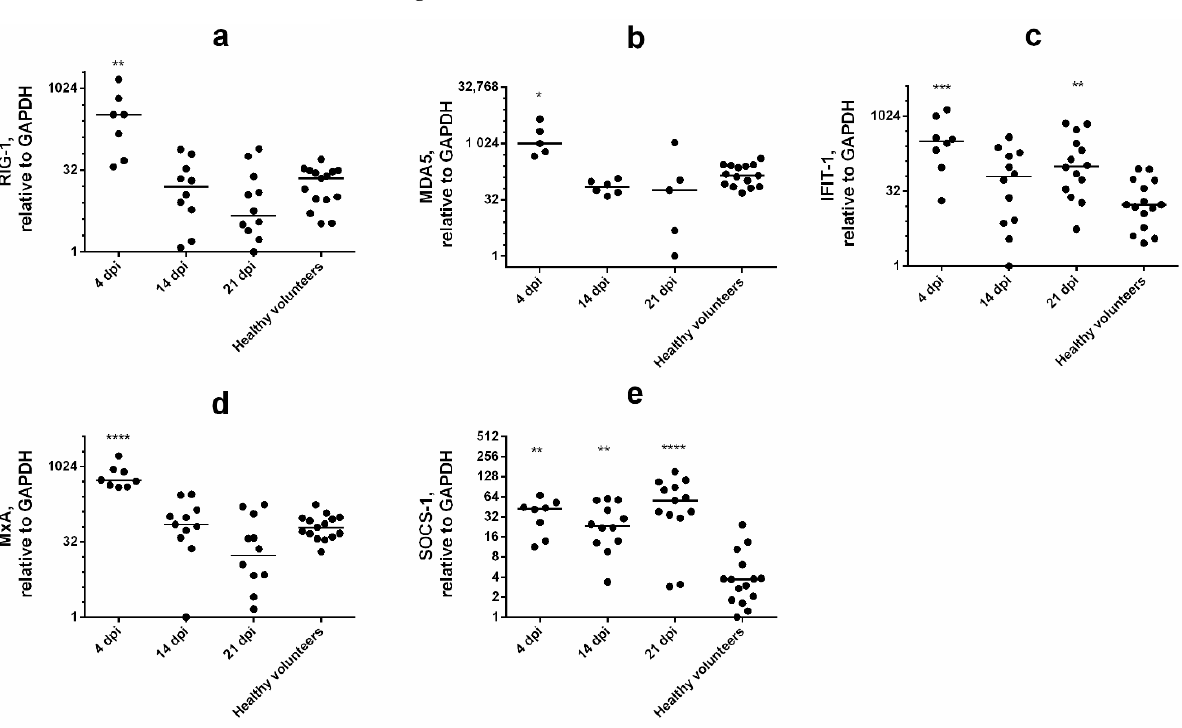
Figure 5. SOCS-1 expression is increased in WBCs during SARS-CoV-2 infection. The mRNA levels of RIG-1 ( a ), MDA5 ( b ), IFIT-1 ( c ), MxA ( d ), and SOCS-1 ( e ) were measured via the ∆∆ Ct method (relative to GAPDH). Statistical significance ( p -value) was determined by Kruskal–Wallis test, followed by Dunn’s multiple comparisons test; ****—adjusted p Value < 0.0001; ***—<0.001; **—<0.01; *—<0.05 compared to healthy volunteers. Data are represented as median.